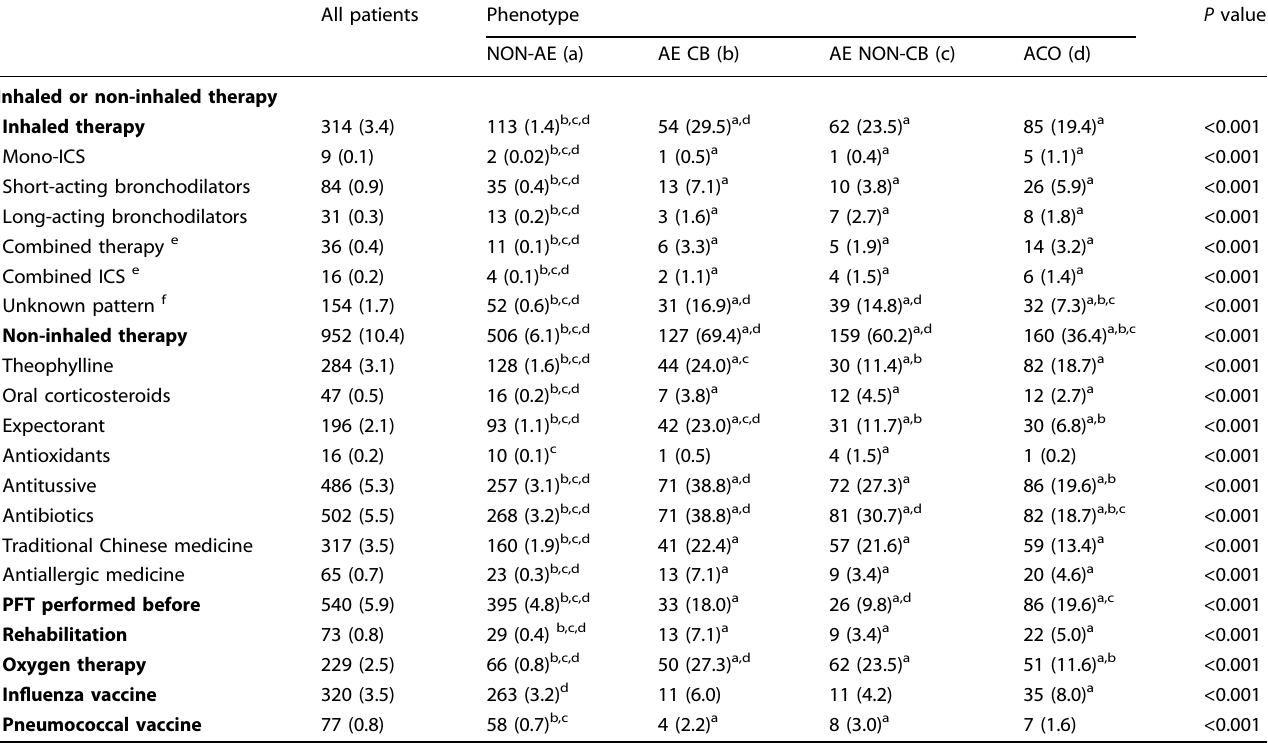
Table 3. Treatment and prevention in patients with chronic obstructive pulmonary disease according to phenotype. All